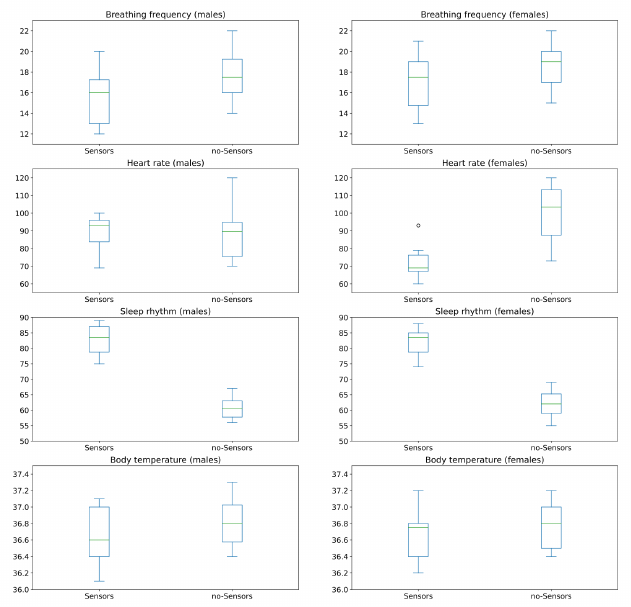
Figure 13. Box plots for sensor and no-sensor categories for men and women. (C) Male subjects: